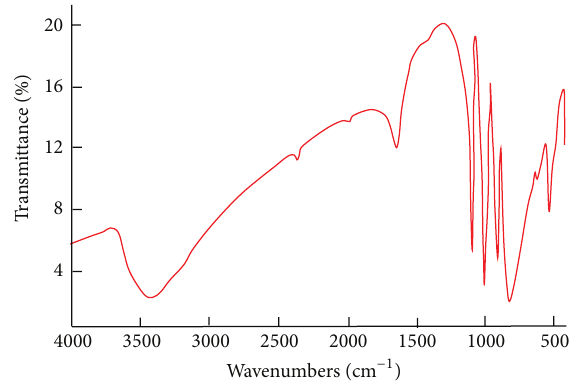
Figure 1: IR spectrum of H 3 PW 12 O 40 .